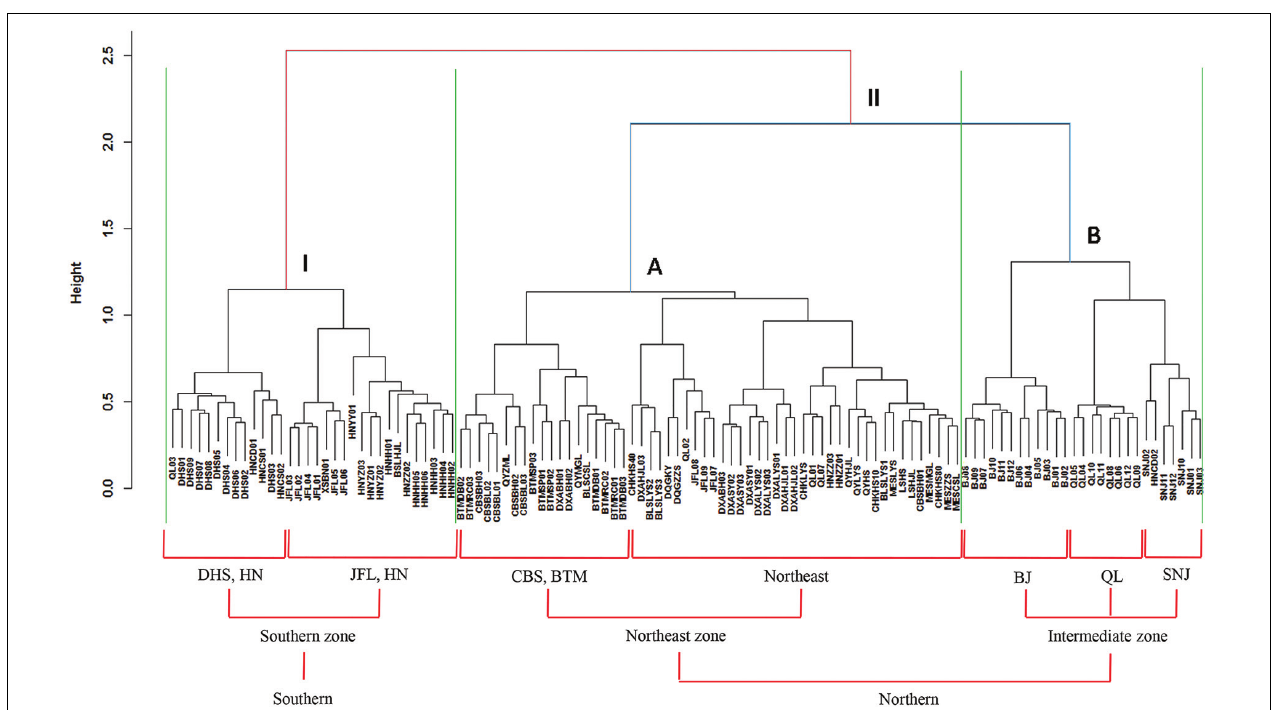
FIGURE 7 | Cluster analysis of bacterial communities based on “Bray–Curtis” dissimilarity matrix. The symbols located at the ends of the cluster branch represented all the 115 soil samples and their detailed information are listed in Supplementary Table S1. All the 115 soil samples were clustered into two main groups (I and II) which were roughly corresponding to southern and northern forest soils, respectively. Moreover, the group II was coarsely divided into two subgroups (A and B) which were mainly from northeast zone forest soils and intermediate zone forest soils,